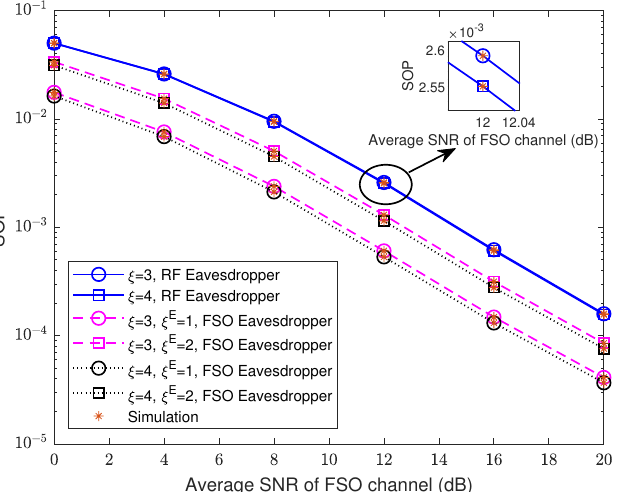
Figure 9. Under different ξ and ξ E conditions, the relationship between the SOP of the hybrid system with RF and FSO link eavesdropping and the average SNR of the FSO channel.